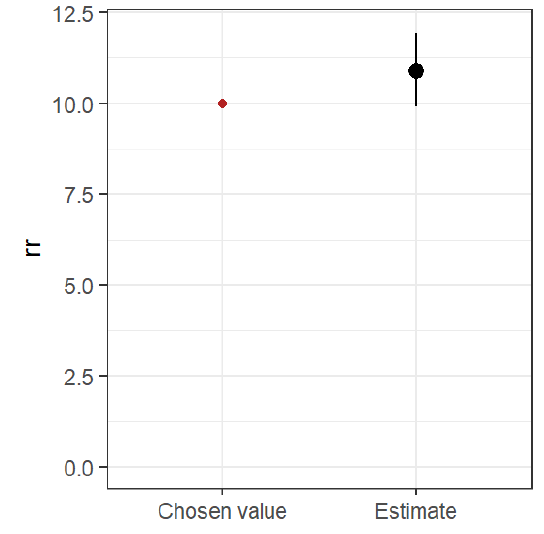
Figure S8. Estimated value of the relative risk of hospitalization among non-vaccinated compared to vaccinated compared to the value chosen to simulate the